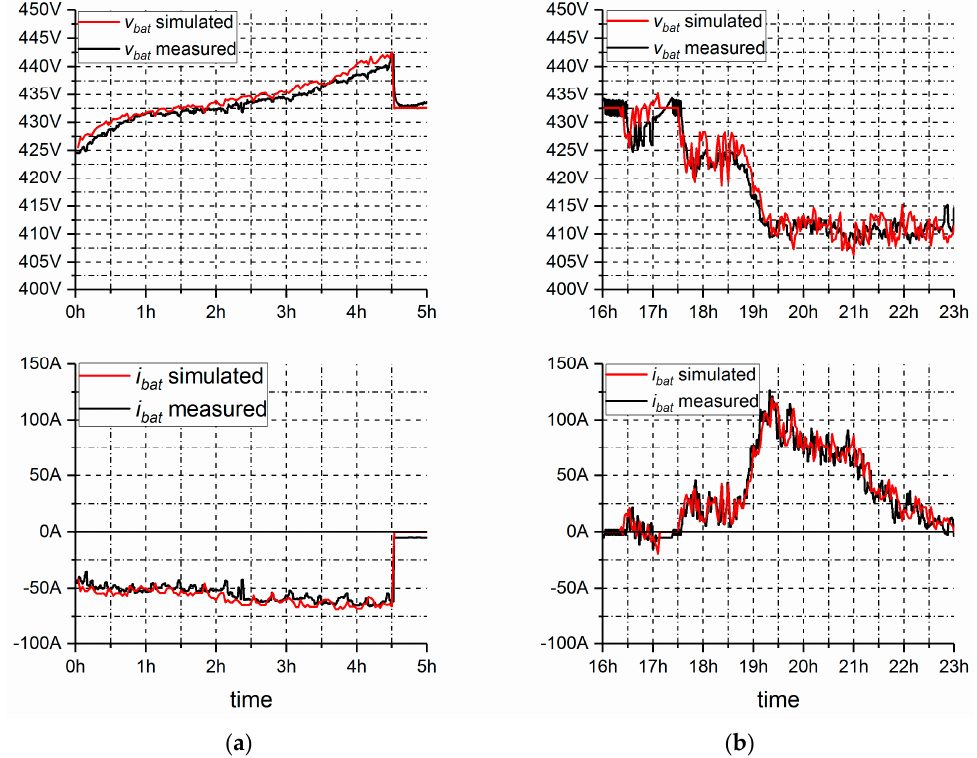
Figure 19. Simulation and measurement results for Rint model ( a ) charging and ( b ) discharge.